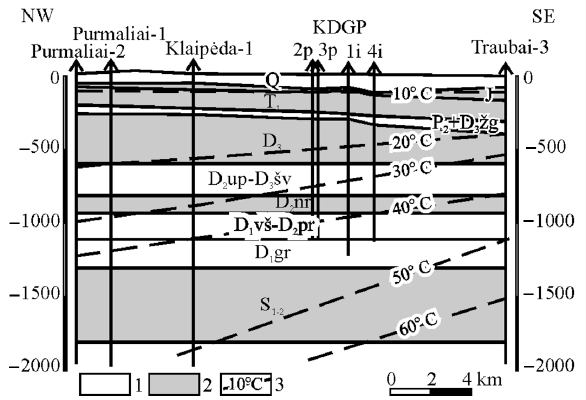
Fig. 2. Hydrogeological cross-section of KDGP: 1 –